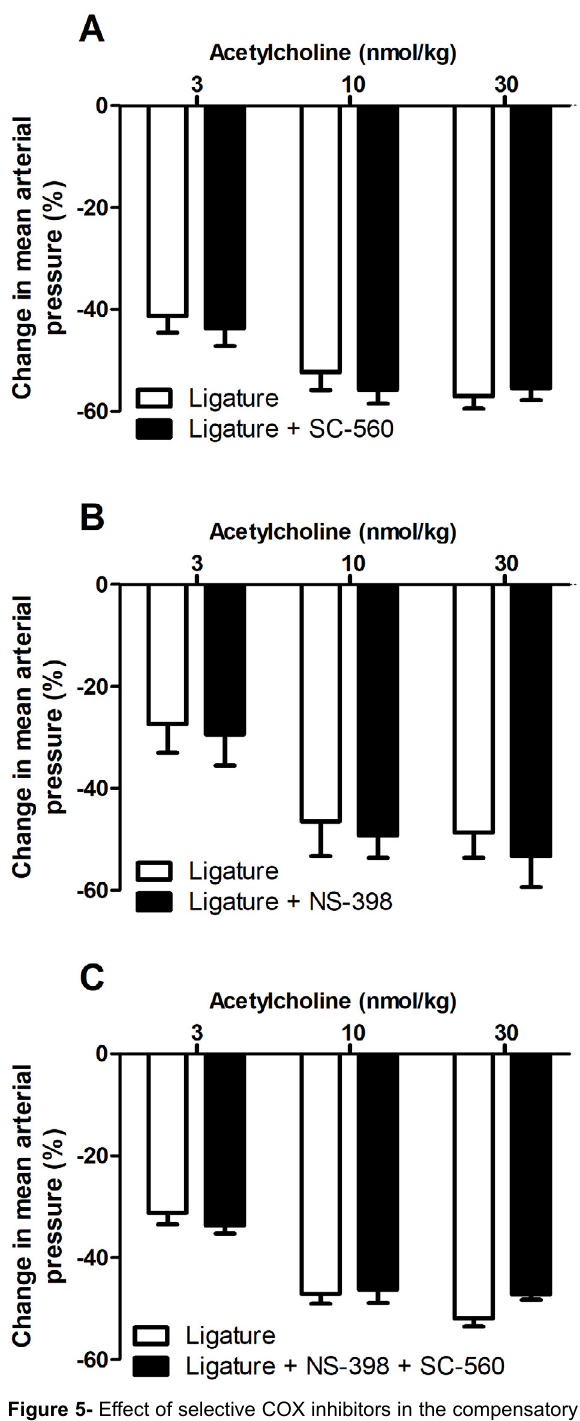
Figure 5- Effect of selective COX inhibitors in the compensatory